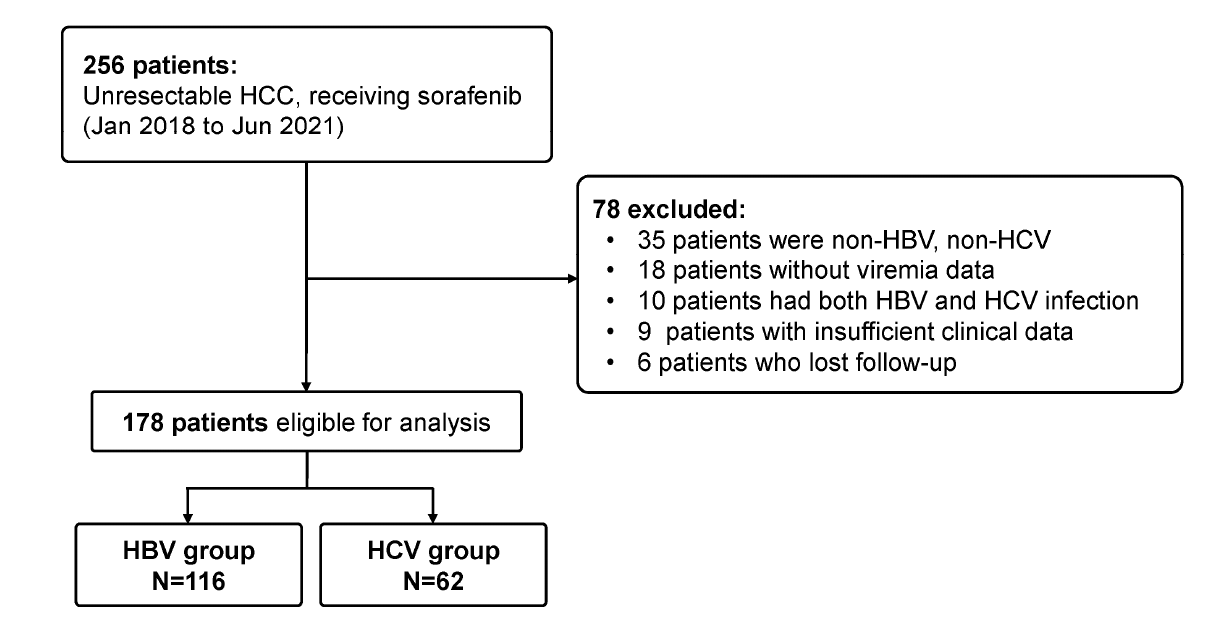
Figure 1. Flow chart of all enrolled patients. Table 1. Demographics and clinical characteristics of enrolled HBV-HCC patients and HCV-HCC